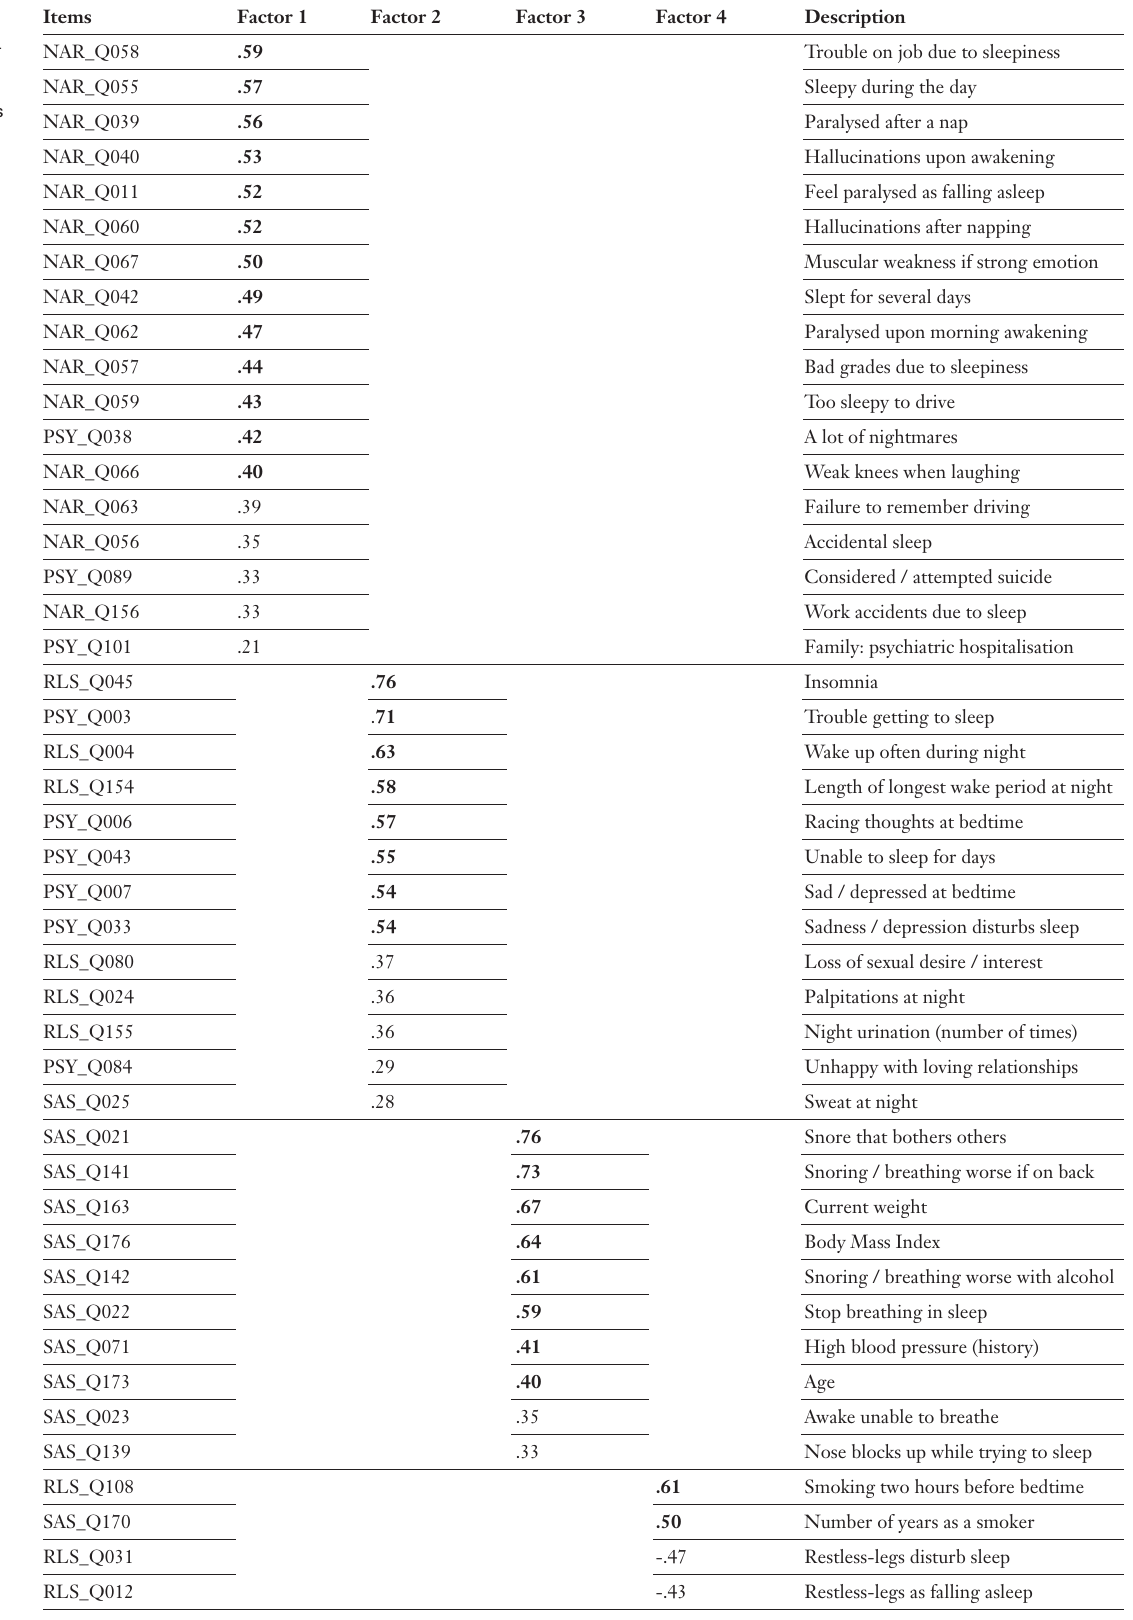
Factor analysis, coef- ficients ≥ .4 are bold. The questions are la- belled as in Douglass et al. 1994, and ordered according to factor analysis. Factor loadings below 2 are not shown. N =